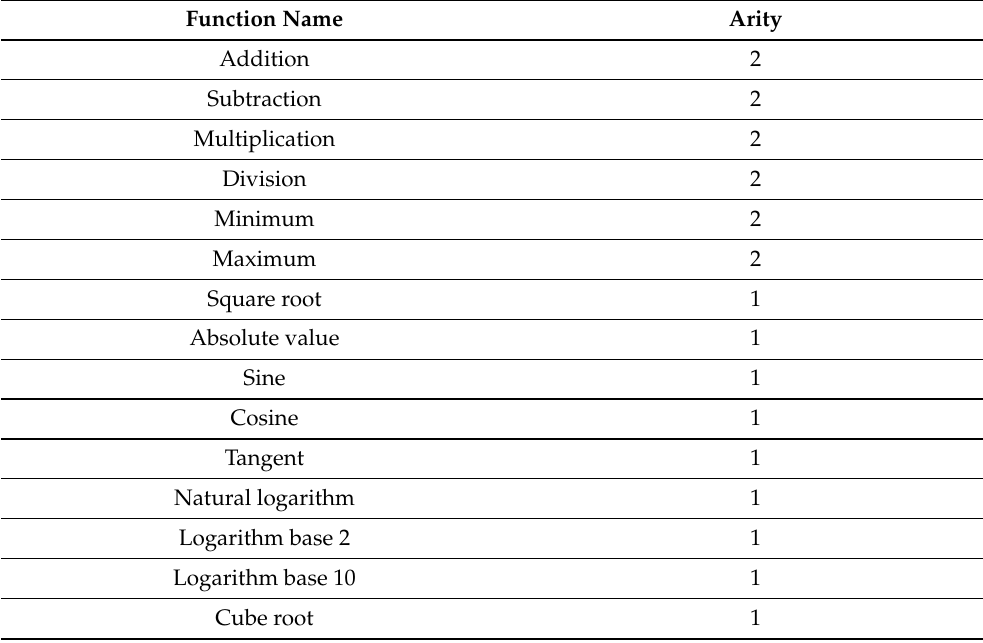
Table 6. The list of mathematical functions